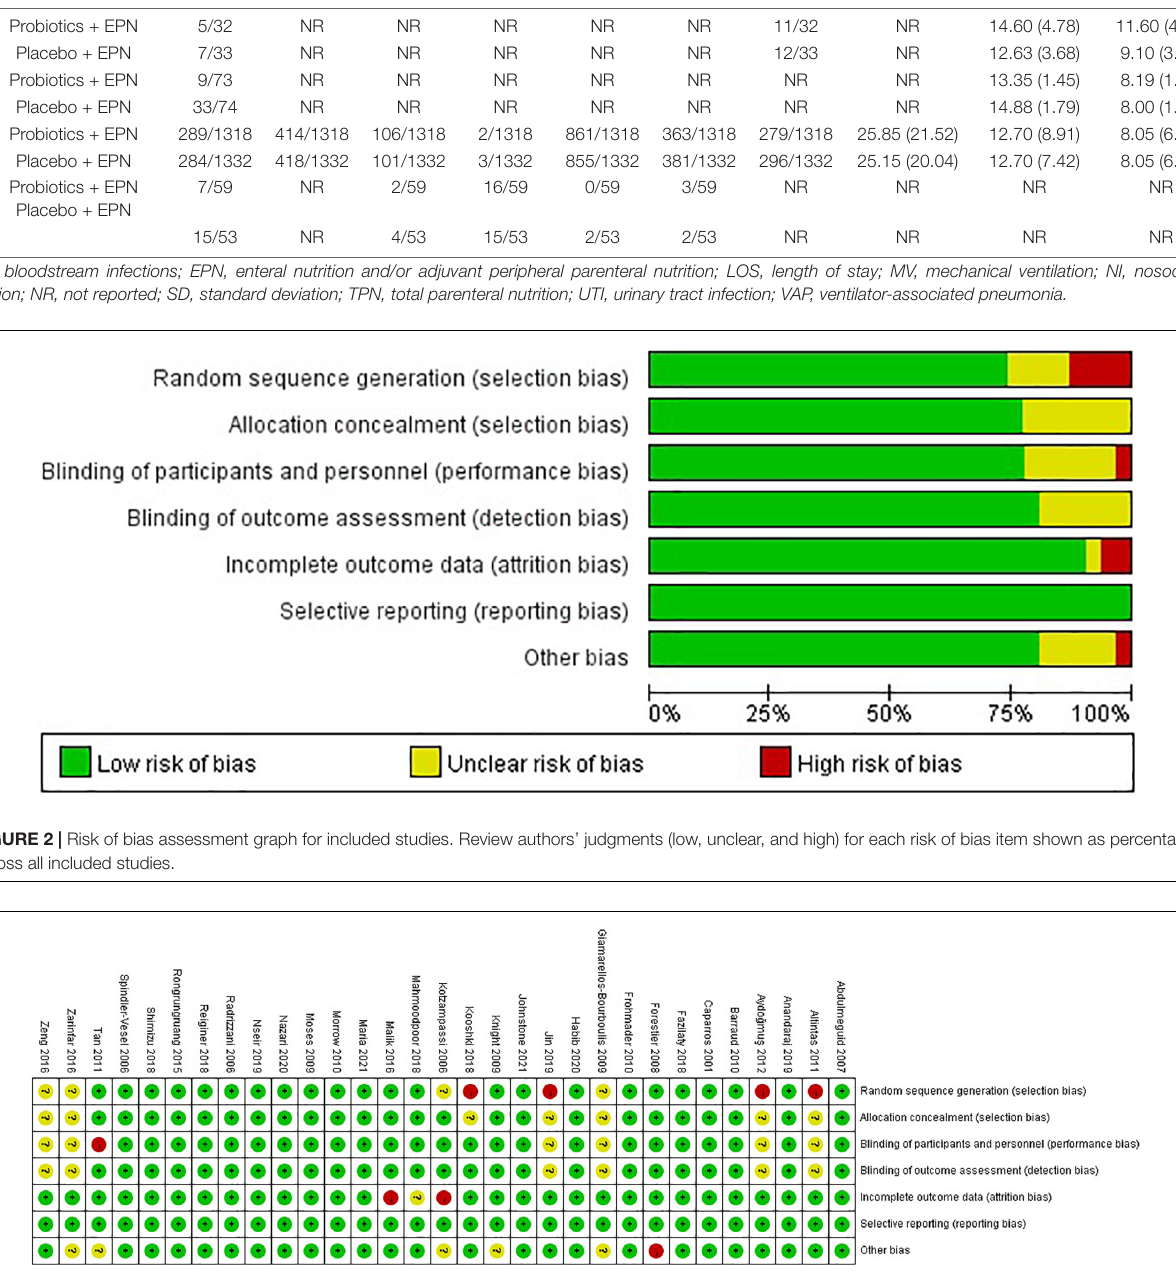
FIGURE 3 | Risk of bias summary for included studies. Studies were classified as having low ROB if none was rated as high ROB, and three or less were rated as unclear risk. Studies had moderate ROB if one was rated as high ROB or none was rated as high ROB but four or more were rated as unclear risk. All other cases were assumed to pertain to high